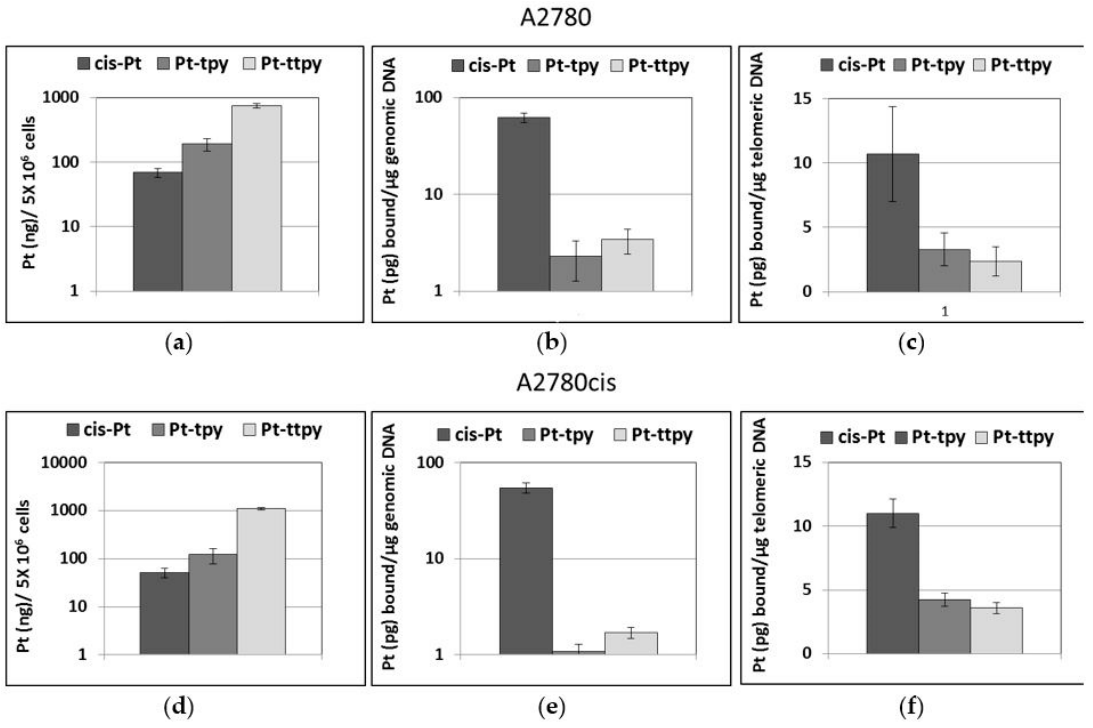
Figure 3. Quantification of the intracellular levels (left panel), of cisplatin, Pt-ttpy and Pt-tpy after 8 h treatment with 50 µ M platinum complexes of A2780 cells ( a – c ) or A2780cis cells ( d – f ); of platinum bound to genomic DNA (middle panel) and bound to telomeric DNA (right panel).